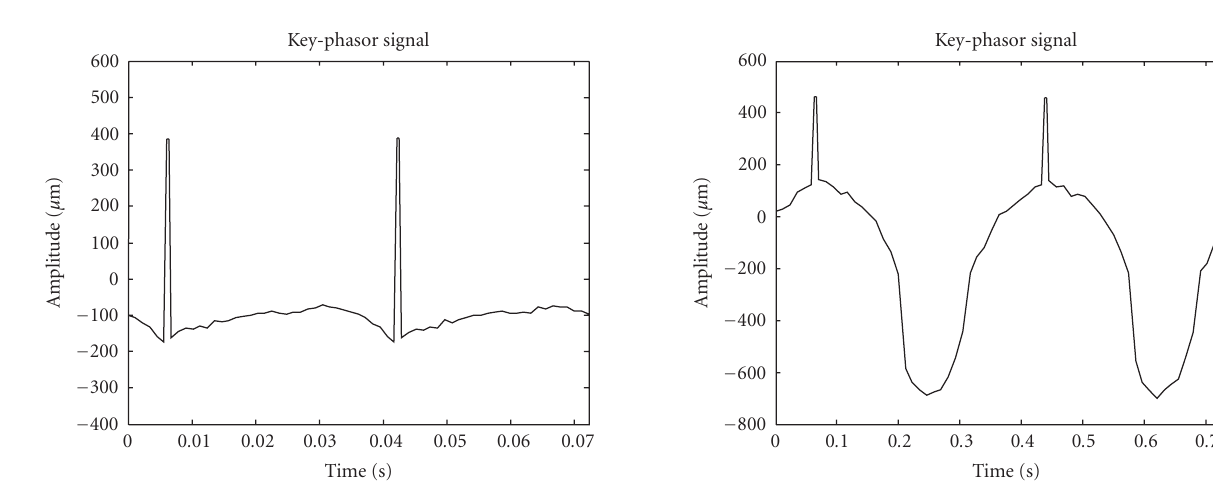
Figure 7: Time history of the lateral vibrations measured by the key-phasor probe at the end of the coastdown carried out after the rub occurrence. Rotating speed: 160 rpm.